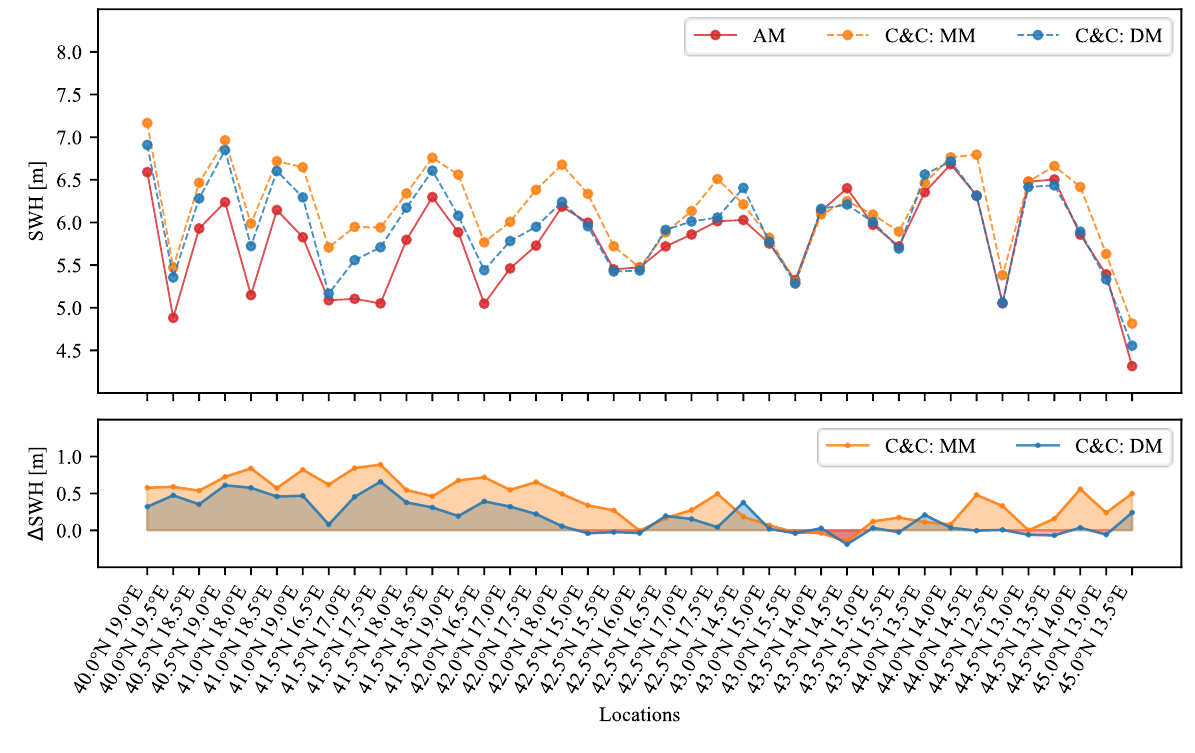
Figure 4. The extreme SWHs for the return period of 25 years. The blue dashed line represents long-term predictions calculated using system probability distribution obtained by the C–C method combining probability distributions of DM. The orange dashed line combines distributions of MM. The red line represents the conventional method using AM, neglecting both effects. Moving from left to right on the horizontal axis corresponds to moving across locations from southeast to northwest. The lower graph displays the differences between the given C–C and the AM